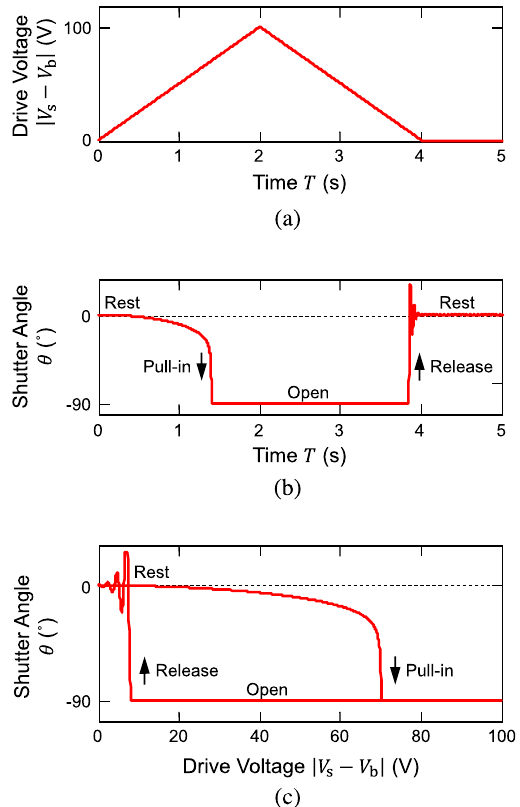
Figure 6. Equivalent-circuit simulation results of electrostatic shutter operation (rest - open). ( a ) Drive voltage waveform used for simulation and ( b ) calculated shutter angle waveform. ( c ) Shutter angle as a function of drive voltage.